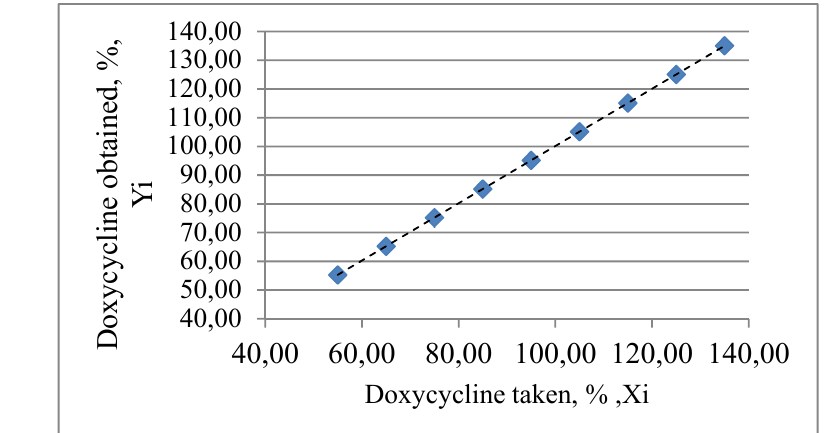
Fig. 1. The graph of linear dependence of absorbance on doxycycline solution concentration Accuracy was assessed by two criteria: criterion of statistical non-significance and practical non-significance criterion.